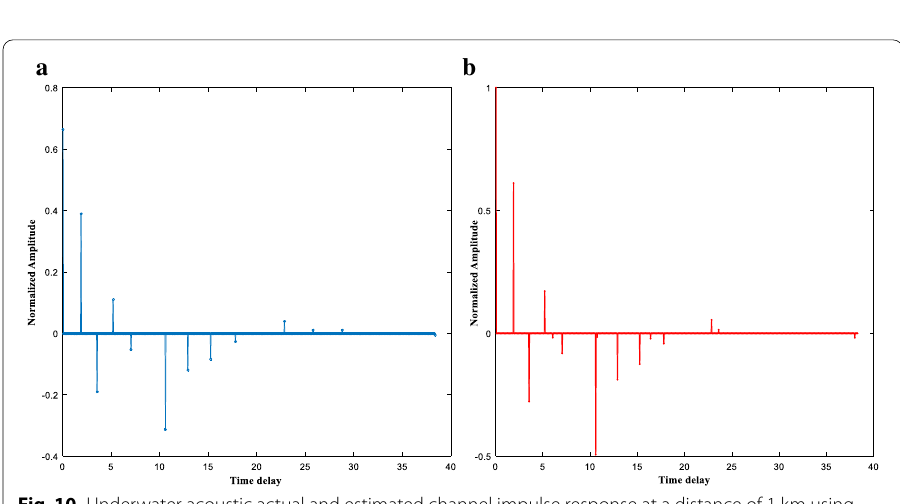
Fig. 10 Underwater acoustic actual and estimated channel impulse response at a distance of 1 km using BELLHOP a actual impulse response, b estimated impulse response using matching